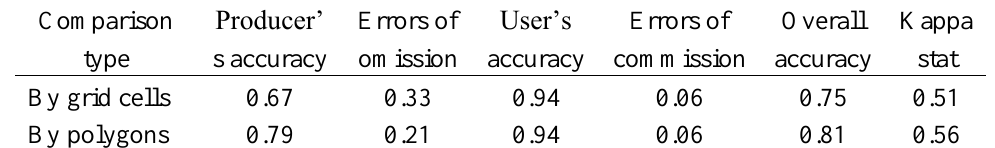
Table 3. Error matrix summary of irrigated lands between MIrAD-US and UND ground observation sites for the Great